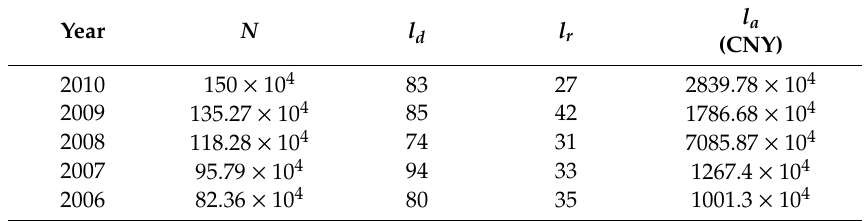
Table 3. Statistics on accidents related to hoisting machinery in China from 2006 to